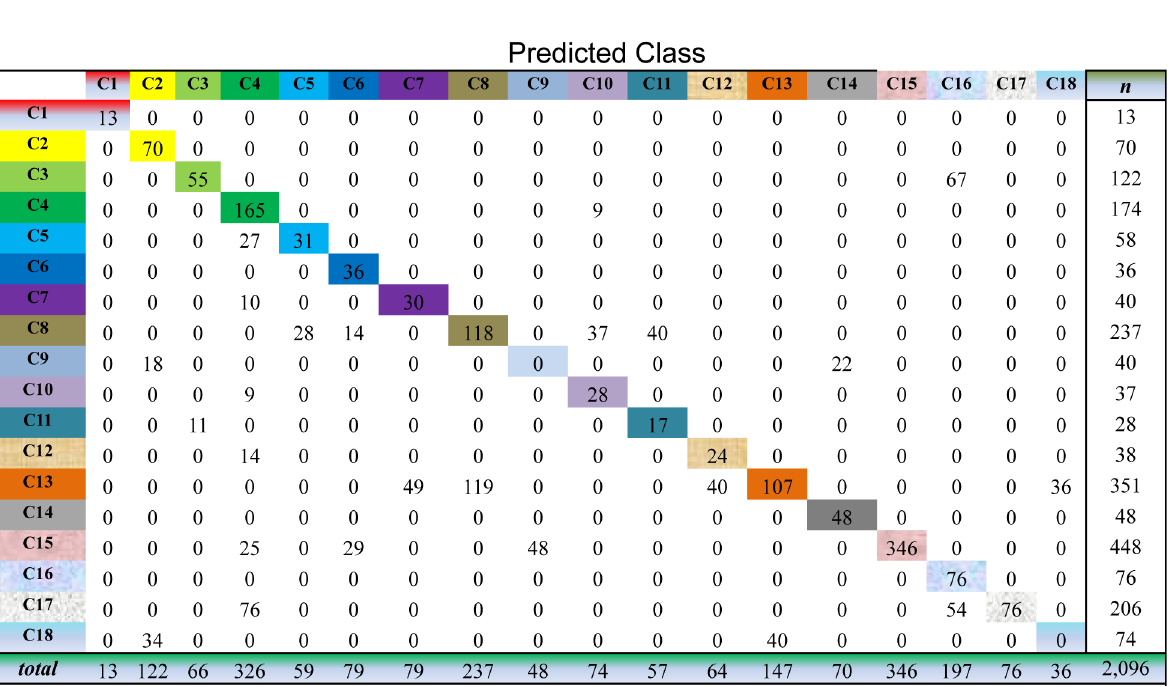
Fig 12. Confusion matrix of prediction results using LDS, which achieves a total accuracy of 59.16%. Matrix delineates distribution of actual compared with predicted class membership for multiclass cancer prediction on the Acute Leukemia